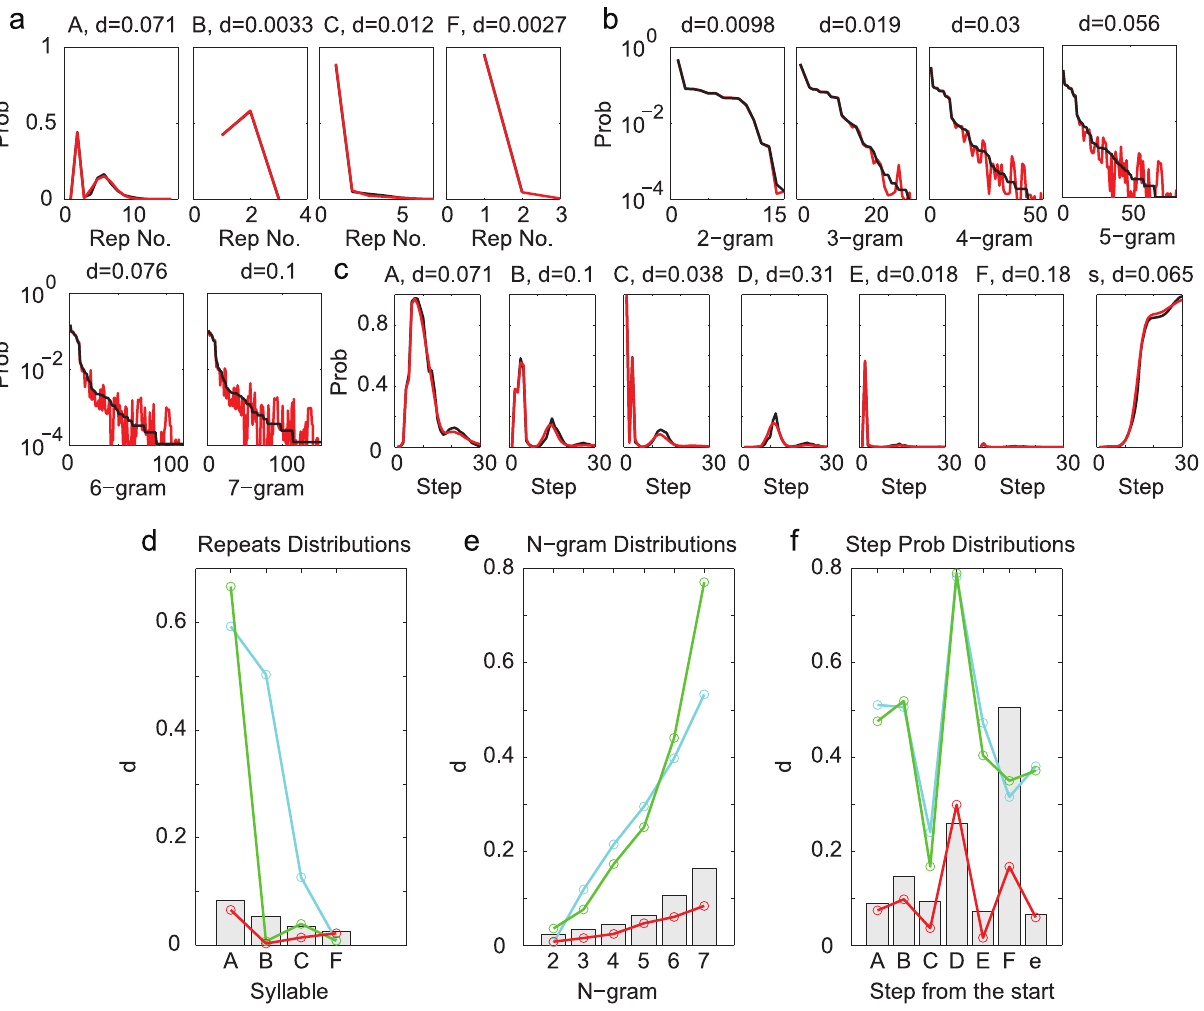
Figure 10. Comparisons of the models and data (Bird 2). The repeat ( a ), the N-gram ( b ) and the step probability ( c ) distributions are compared for the observed (black curves) and the POMMA-generated (red curves) sequences. d, e, f. Summary of the differences between the model-generated and observed distributions for the Markov model (cyan curves), the Markov model with adaptation (green curves), and the POMMA (red curves). The gray bars are the benchmarks obtained from the observed syllable sequences.